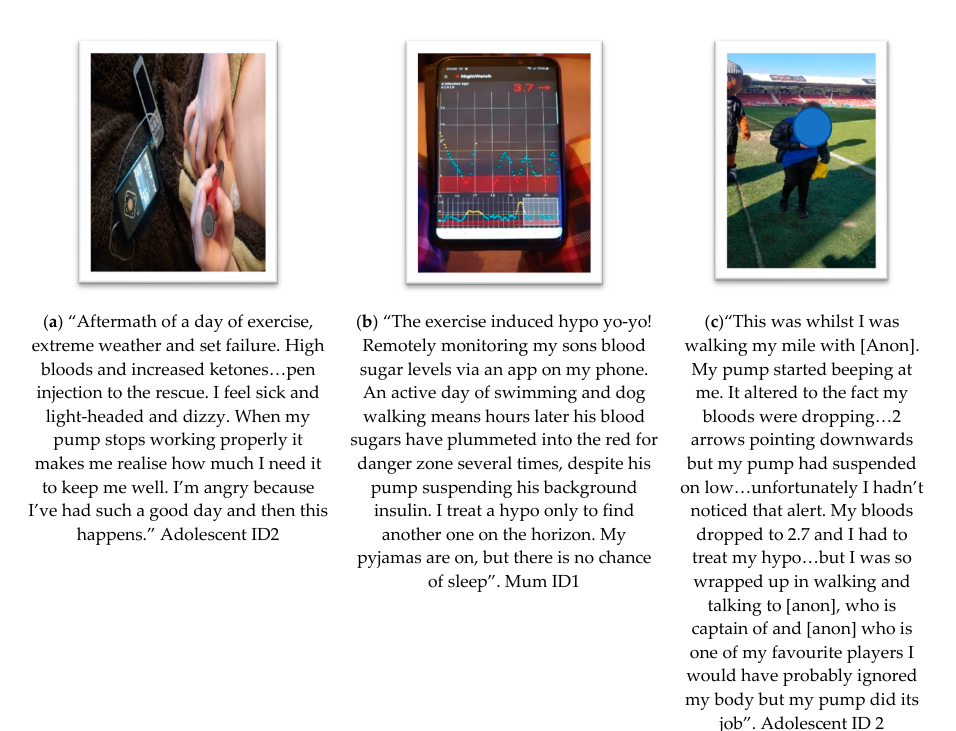
Figure 5. Photovoice submissions representing theme 4, reliance and risk, showing data interpreted as the following sub-themes: ( a ) tech fails and severe life risk; ( b ) trust and vigilance; ( c ) alerts and